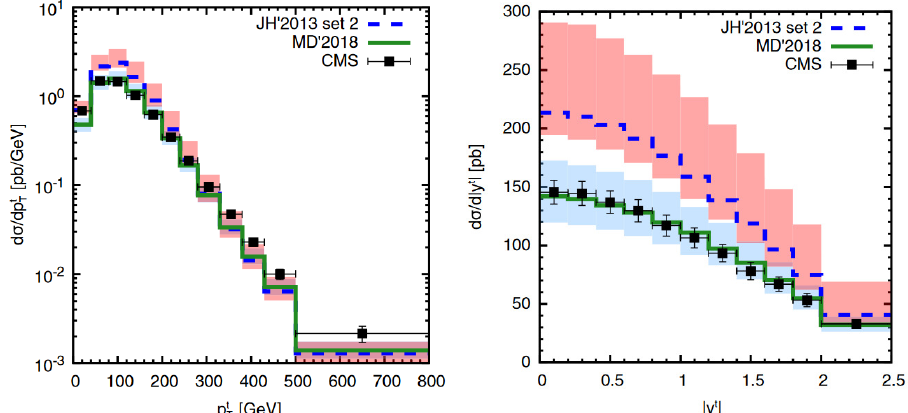
Figure 1. The transverse momentum and rapidity distributions of inclusive t ¯ t production √ in pp collisions at s = 13 TeV. The green (solid) and blue (dashed) curves correspond to the predictions obtained using the MD’2018 and JH’2013 set 2 gluons, respectively. The shaded bands represent their scale uncertainties. The experimental data are from CMS [19]